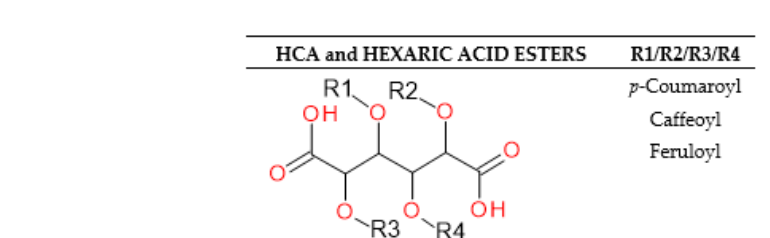
Figure 2. Structures of the flavonols and HCAs identified in the G. officinalis herb.